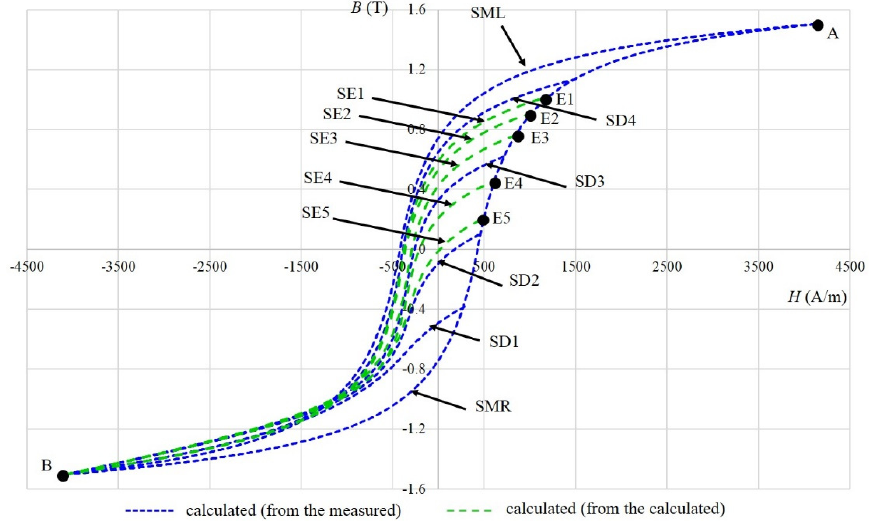
Figure 11. Calculated curves based on the measured curves (SML, SMR, SD1–SD4) and calculated curves in the area between the measured curves SE1–SE5.